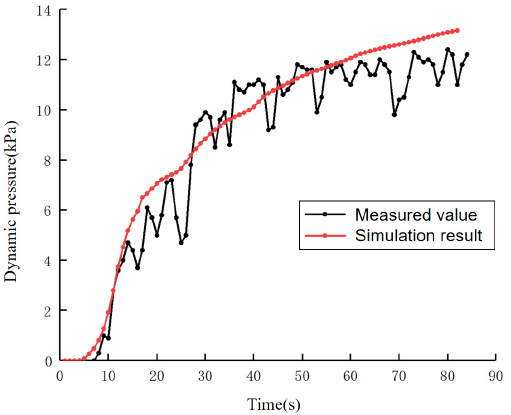
Figure 5. Comparison of dynamic pressure of measurement and simulation.